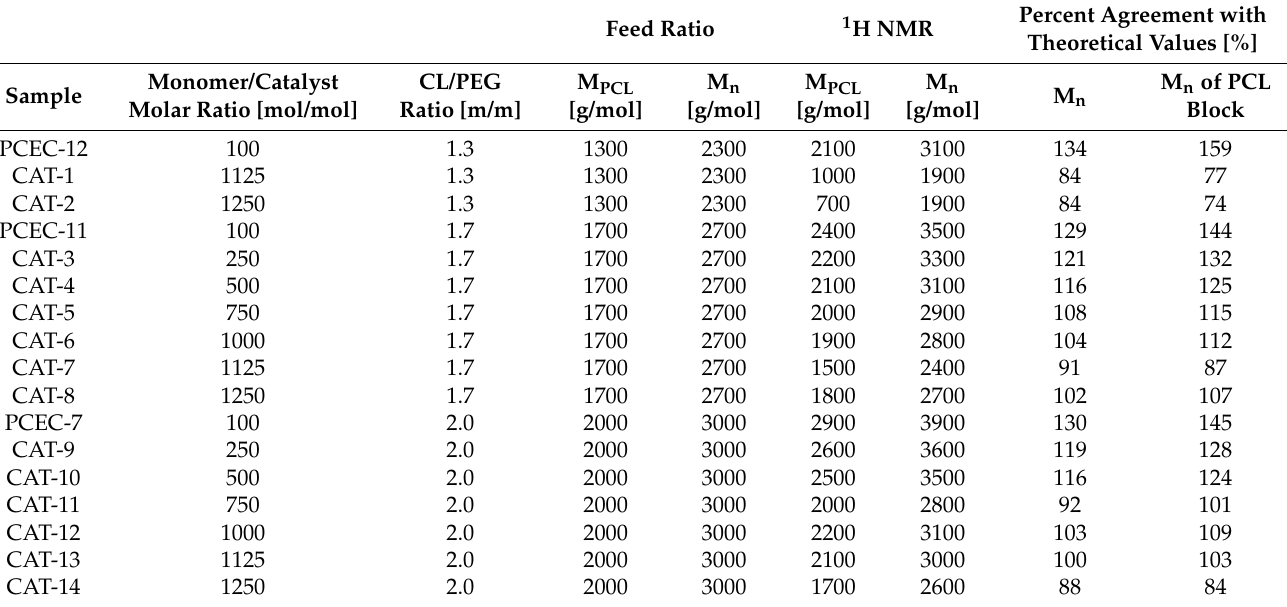
Table 2. Optimization of the CL/catalyst molar ratio.